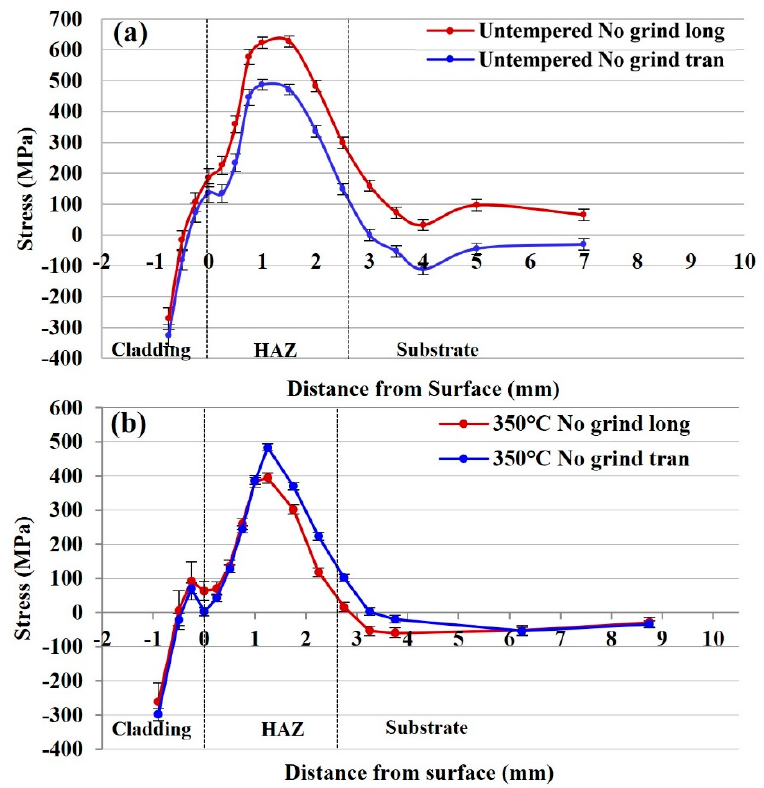
Figure 5. ( a ) Residual stress distribution of the untempered 415SS clad rail and ( b ) residual stress distribution of the 350 °C tempered, 415SS clad rail with no surface grinding. (long—-longitudinal tran—transverse.)